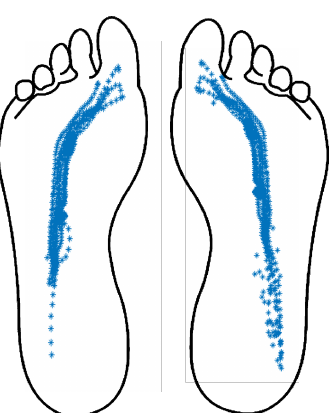
Figure 8. CoP calculated from all gait cycles with the developed system, for one volunteer.